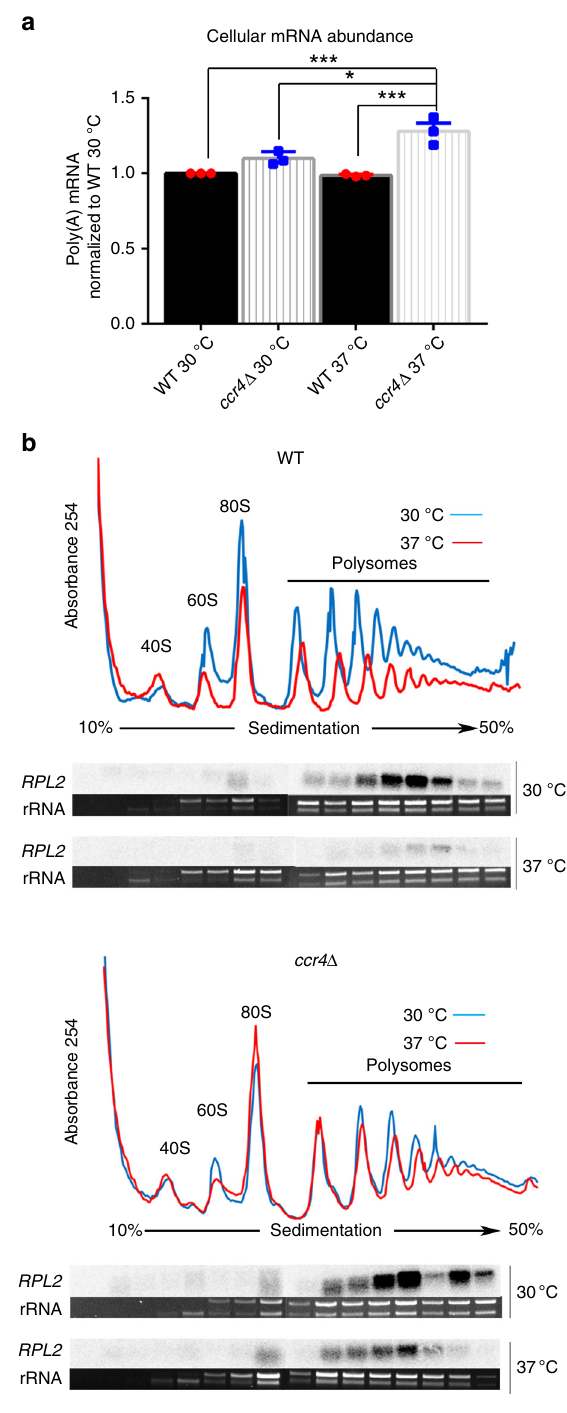
Fig. 3 Stabilized RP transcripts are retained in the actively translating pool. a Equivalent amounts of the total RNA from cultures grown at 30 °C or shifted to 37 °C for 1 h were vacuum fi ltered through a slot blot apparatus onto the nylon membrane. A P32-labeled oligo-dT was used to assess mRNA by northern blot. Graphs show averaged polyA mRNA levels ± s.e.m. from three biological replicates. b Polysome traces show the translational state of each strain during no stress and following a shift to 37 °C for 1 h. Subunits, monosomes, and polysome are indicated. RNA was extracted from fractions collected during polysome pro fi ling for wild-type and ccr4 Δ